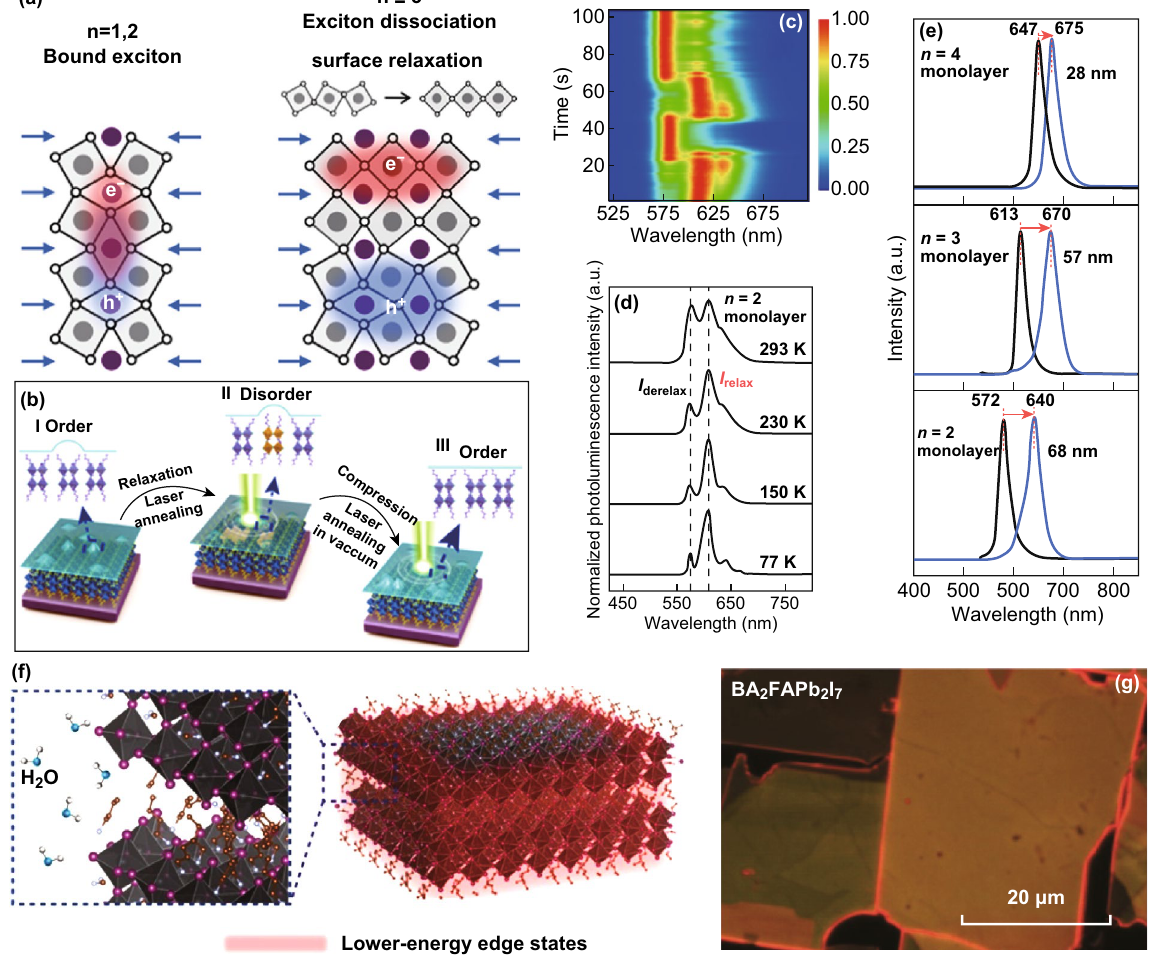
Fig. 9 a Schematics of the surface-induced exciton dissociation in R–P perovskites with n ≥ 3. Reprinted with permission from Ref. [73]. Copy- right American Chemical Society. b Schematic diagram showing the order–disorder transition by laser illumination. c Photoluminescence color map showing two continuous cycles of photoluminescence shifts during order–disorder transition, plotted as a function of laser irradiation time, emission wavelength and intensity. d Temperature-dependent changes in photoluminescence intensity. e Photoluminescence of n = 2–4 R–P per- ovskite monolayers. Black lines indicate the initial state photoluminescence, and blue lines are photoluminescence after relaxation. Reprinted with permission from Ref. [74]. Copyright Springer Nature. f Schematic of edge states of 2D halide perovskite due to moisture. g PL image of BA 2 FAPb 2 I 7 excited by UV light. Reprinted with permission from Ref. [75]. Copyright American Chemical